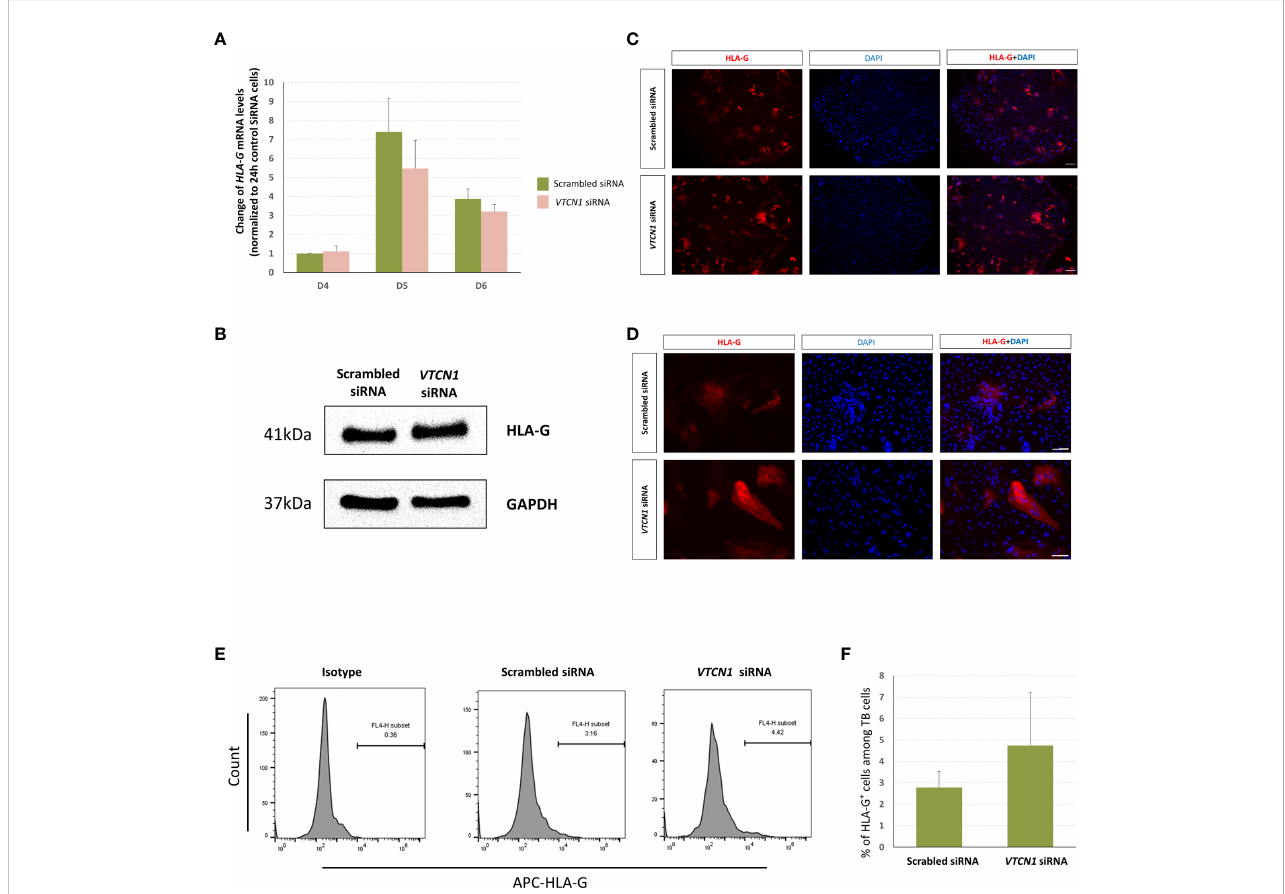
FIGURE 6 H1 ESC on D3 of BAP differentiation were transiently transfected with VTCN1 siRNA or a scrambled siRNA control for 3 d, (A) HLA-G mRNA was assessed by RT-PCR. Data represents means ± SD of three independent experiments; pairwise comparisons were made using Bonferroni methods. No statistically signi fi cant differences were detected in HLA-G transcripts in VTCN1 KD cells when compared to scramble siRNA transfected cells. (B) Protein was collected on BAP d6 (KD d3) and the expression of HLA-G was assessed by western blotting. (C, D) Immuno fl uorescence microscopy was performed to assess the expression of HLA-G on BAP treatment d6 (KD d3) (Scale bar, 100 µm). (E, F) Cells were collected on BAP treatment d8 (KD d5) and fl ow cytometry was used to track the cell surface expression of HLA-G.